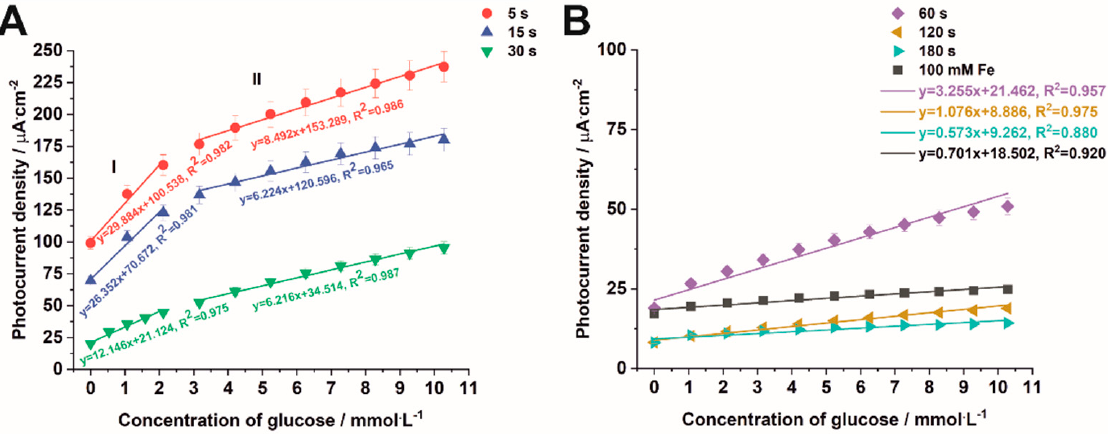
Figure 11. Calibration curves of photocurrent density against the concentration of glucose for Fe 2 O 3 – TiO 2 electrodes obtained by electrodeposition carried out for 5–30 s ( A ) and for 60–180 s together with the sample impregnated in a 100 mM FeCl 3 solution ( B ).